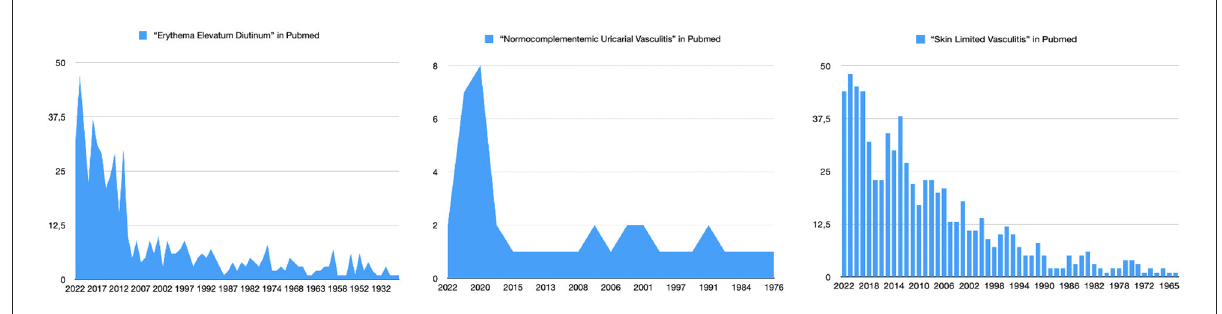
FIGURE1 Count of the articles that used the terms “Normocomplementemic Urticarial Vasculitis”, “Erythema Elevatum Diutinum” and “Skin Limited Vasculitis” over the years in Pubmed.